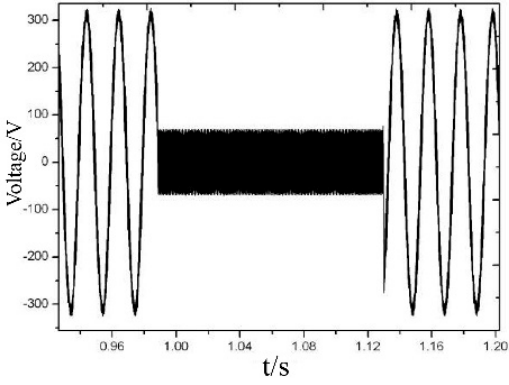
Figure 18. Waveform of voltage interruption.